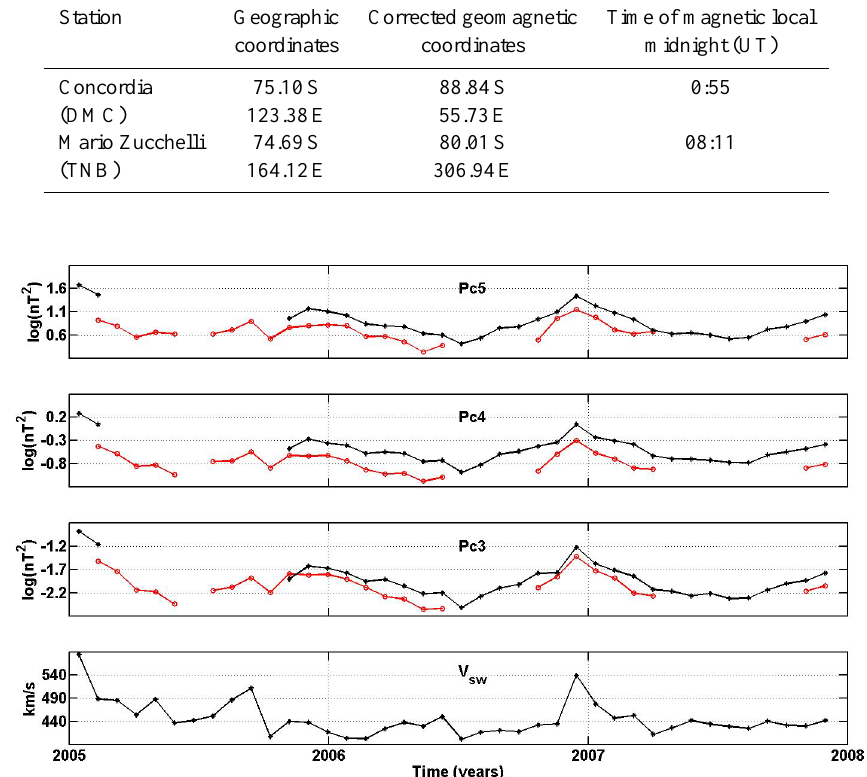
Fig. 1. 27-day averages of ULF power (log scale) at DMC (red line) and TNB (black line) and SW speed through the years 2003–2007. From top to bottom: Pc5 (1–7 ˙mHz), Pc4 (7–22mHz), Pc3 (22–100mHz) power of the horizontal component, SW speed V SW